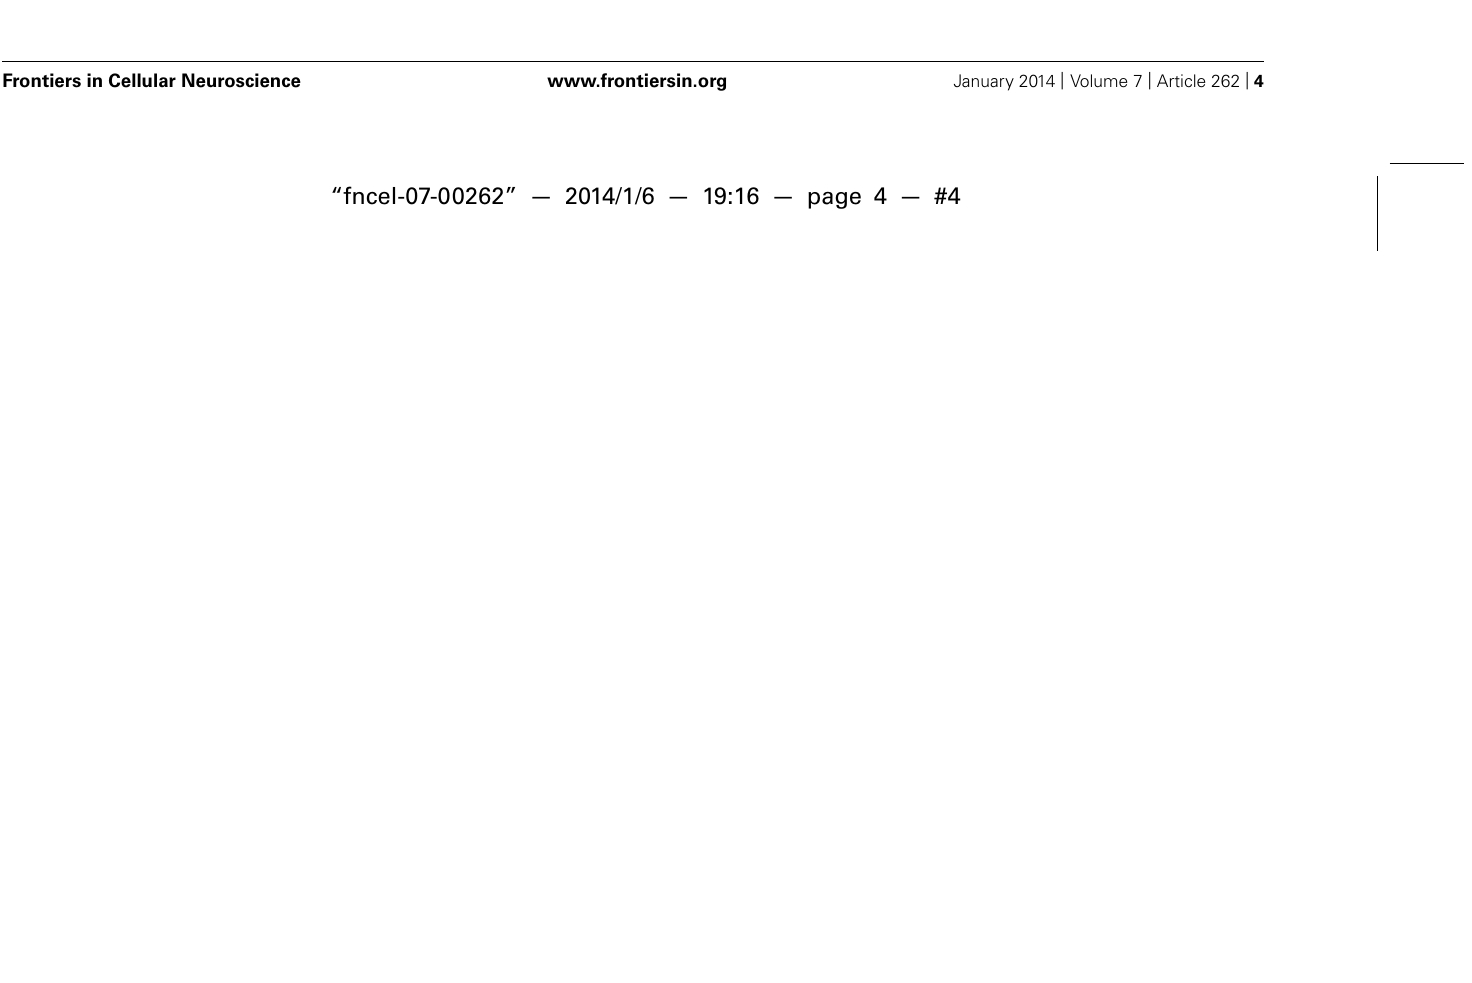
EPSPs elicited in a fast-spiking CA3 interneuron by action potentials in a pyramidal cell [an unpublished data Miles and Wong (B) adapted from Miles,